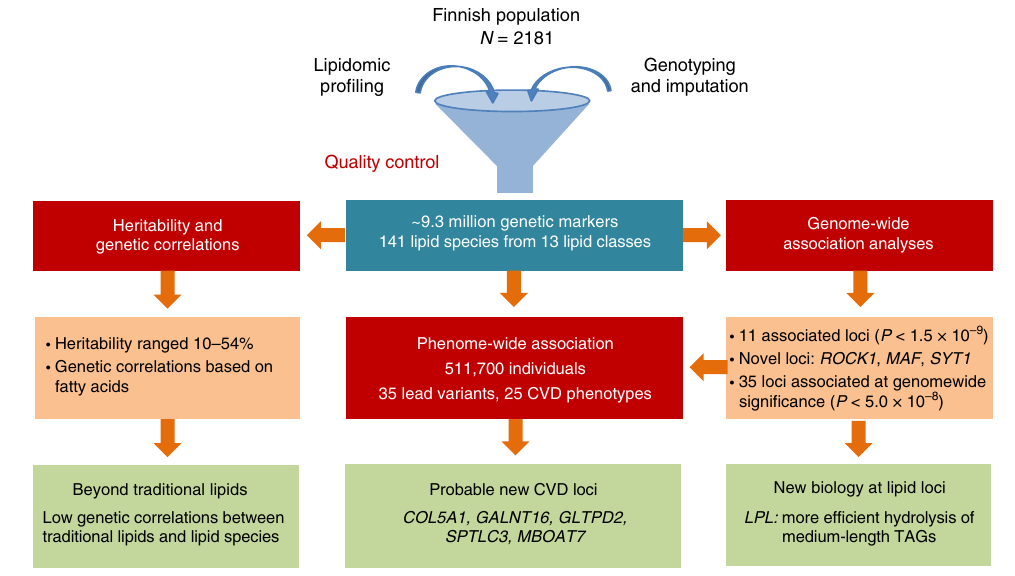
Fig. 1 Study design and work fl ow. The fi gure illustrates the study design and key fi ndings of the